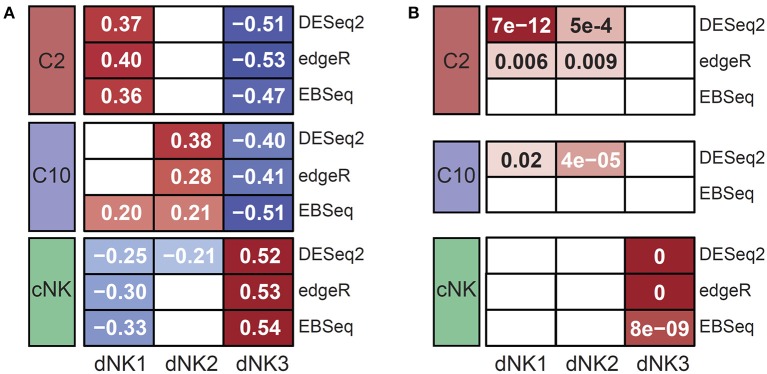
External validation of C10 and C2 by similarity to decidual NKs. Expression levels in C10 and C2 were compared to dNK populations reported by Vento-Tormo et al. (20). (A) Correlation of expression of dNK DE genes between dNKs 1-3 and ILC populations C2, C10, cNK. Shaded cells indicate significant correlations; value is Spearman's rank correlation. (B) Significance of overlap between up-regulated DE gene sets for dNKs 1-3 and ILCs C10, C2, cNK. Shaded cells indicate significant overlap; values shown are hypergeometric test p-values (following Benjamini-Hochberg adjustment for multiple comparisons).